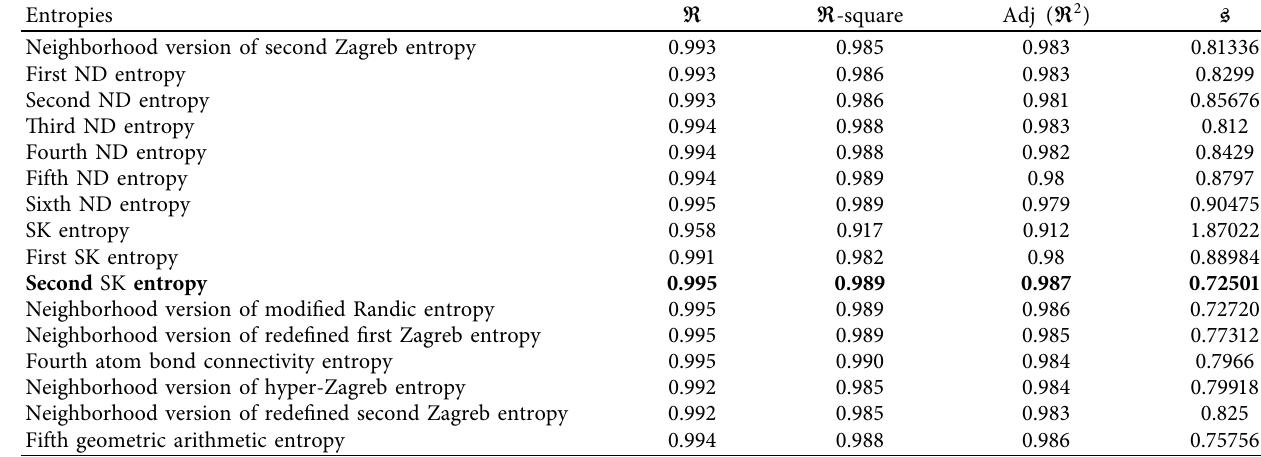
Table 5: The significant LRM: critical pressure ( CP ) of benzene derivatives on indices.